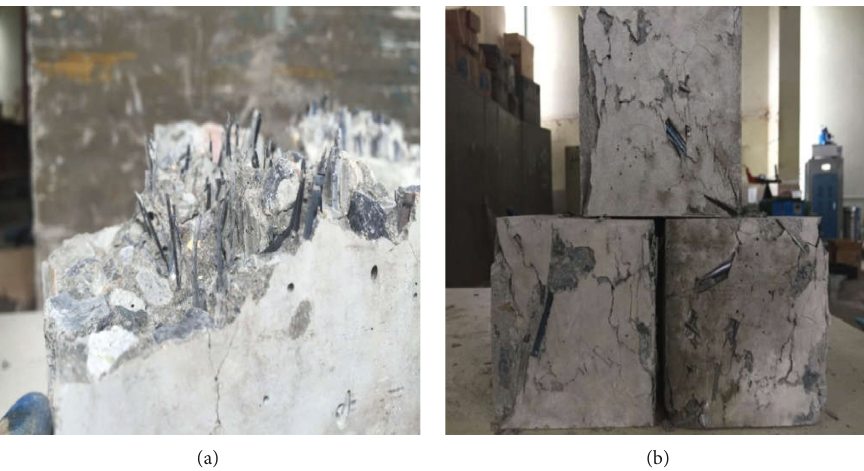
Figure 8: Effects on steel fibre distribution and orientation. (a) Demonstration of the gravity effect. (b) Demonstration of the boundary